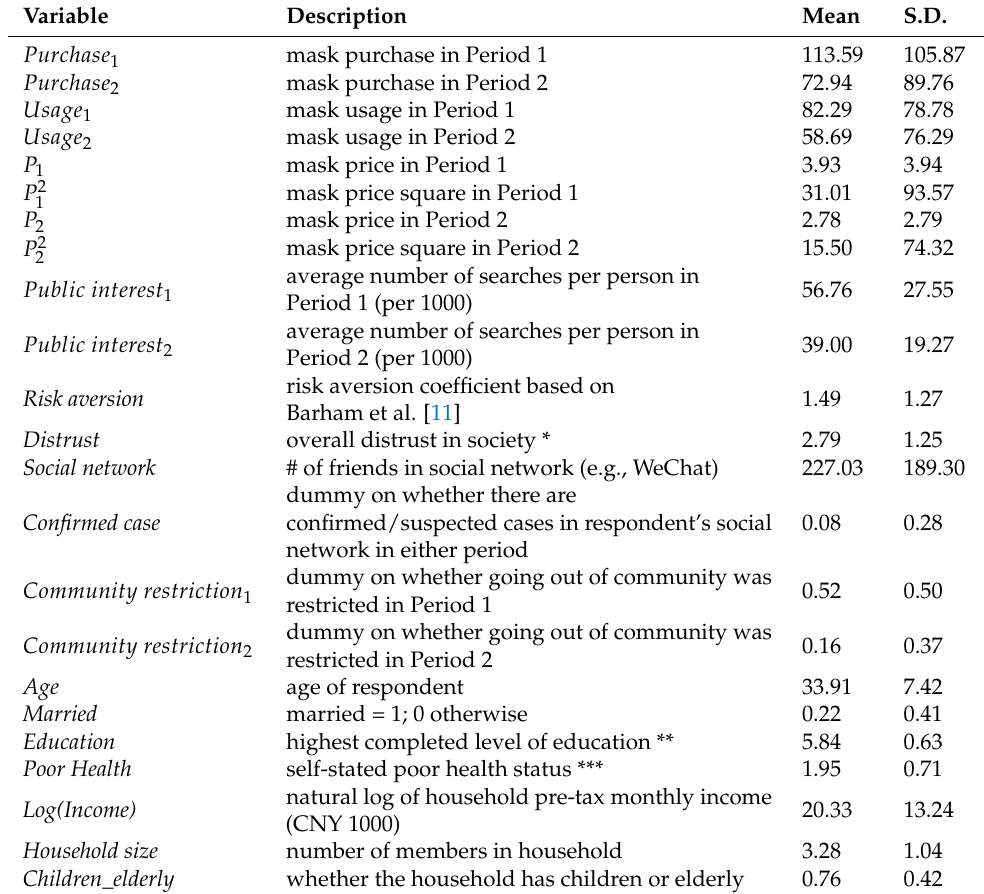
Table 1. Definition and summary statistics of main